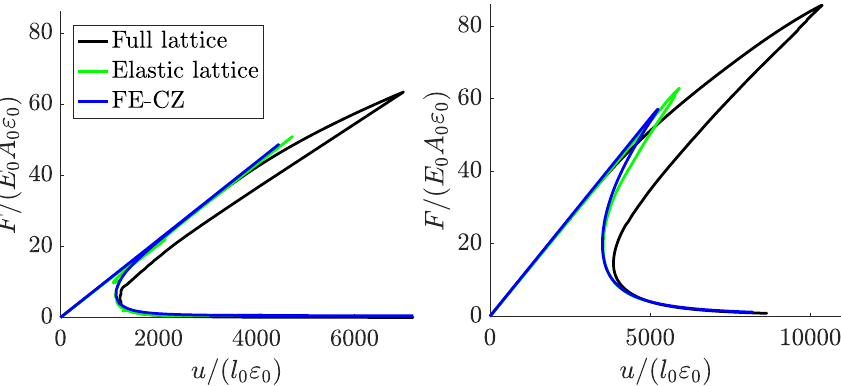
Figure 6. Normalized force–displacement diagrams for a brittle (left) and a ductile (right) lattice. The results of Elastic lattice correspond to the lattice where the damage can evolve only in a narrow band of width 2 l 0 , whereas the remaining lattice is elastic.